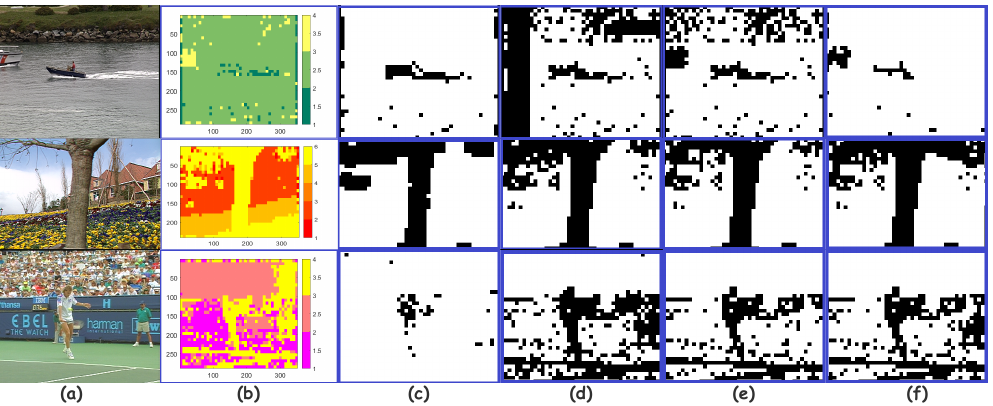
Figure 6. Visual comparisons of foreground motion blocks extraction with global motion among different approaches. ( a ) Sequences (From the top to bottom): Coastguards , Flower , Stefan . ( b ) Motion blocks distribution. ( c ) Our method. ( d ) The GD approach [63]. ( e ) The LSS-ME approach [64]. ( f ) The RANSAC approach